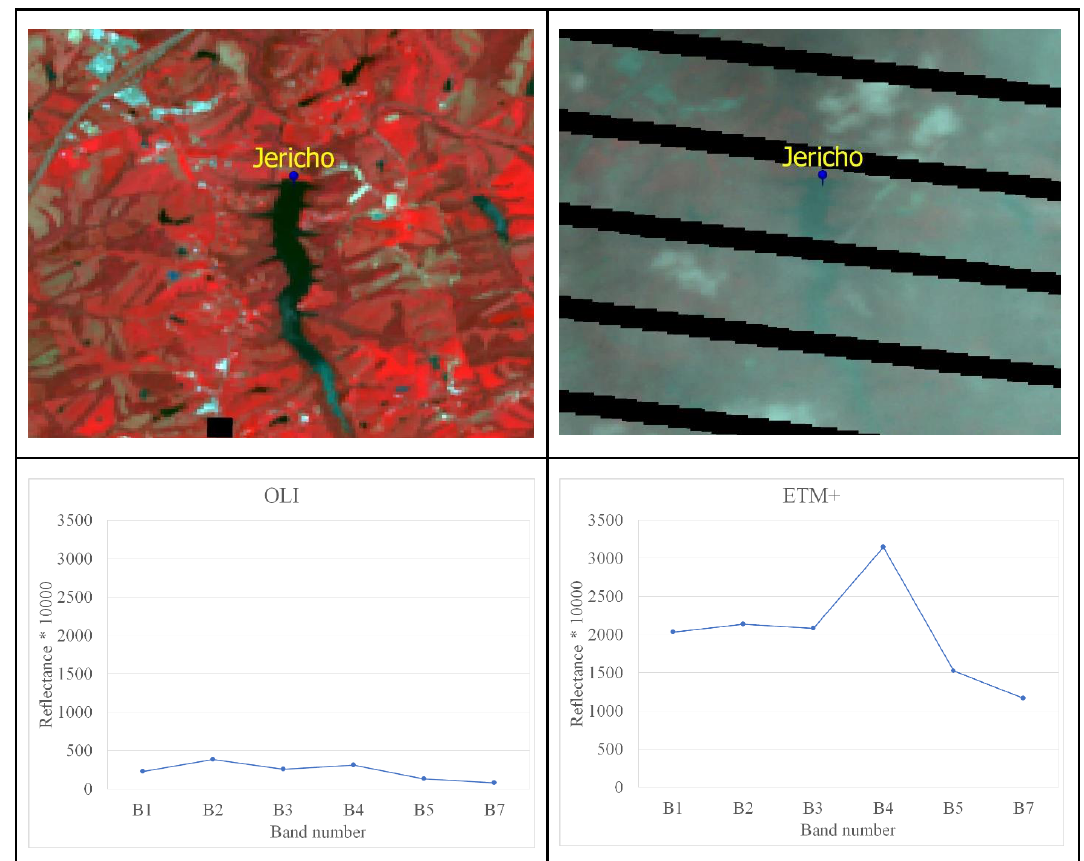
Figure 2. A good quality image pixel of Landsat 8 OLI ( left ) on 05/01/2013 and a poor quality Landsat 7 ETM+ ( right ) on 05/02/2013 with haze contamination matched with the ground samples at the Jericho Lake, Kentucky. The lower panels show the spectral profiles of the pixels marked in the two images.